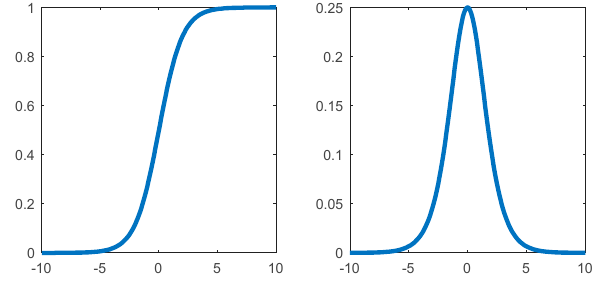
Figure 5. Sigmoid type activation function and its gradient map.